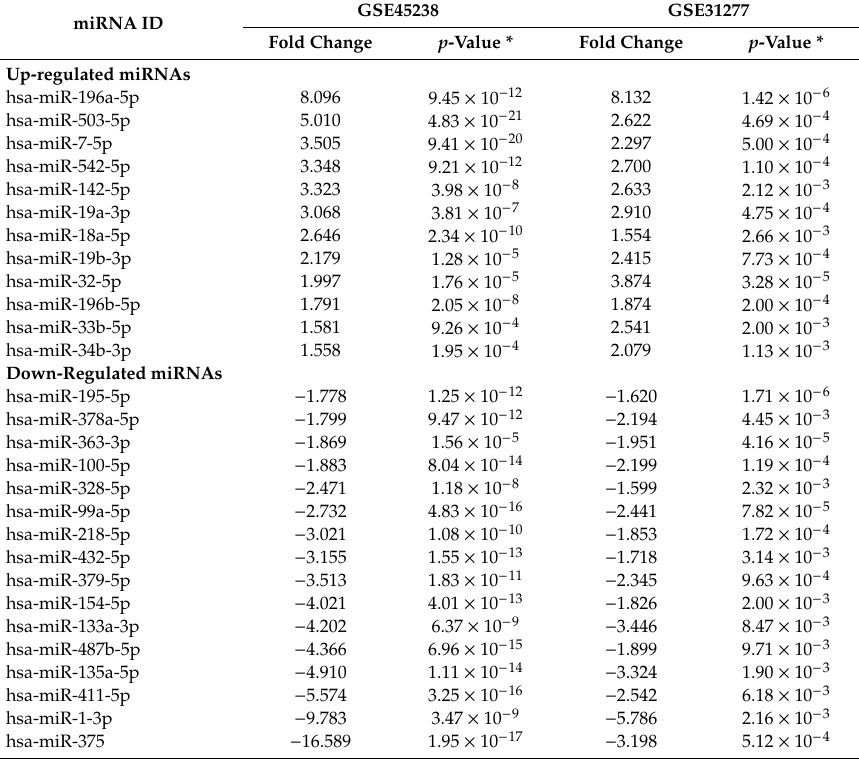
Table 1. Up-regulated and down-regulated miRNAs in tumor samples compared to the healthy